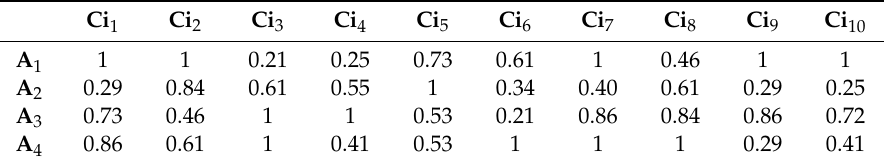
Table 22. The normalized judgments matrix using the weight sum model (WSM) and weight product model (WPM) methods.